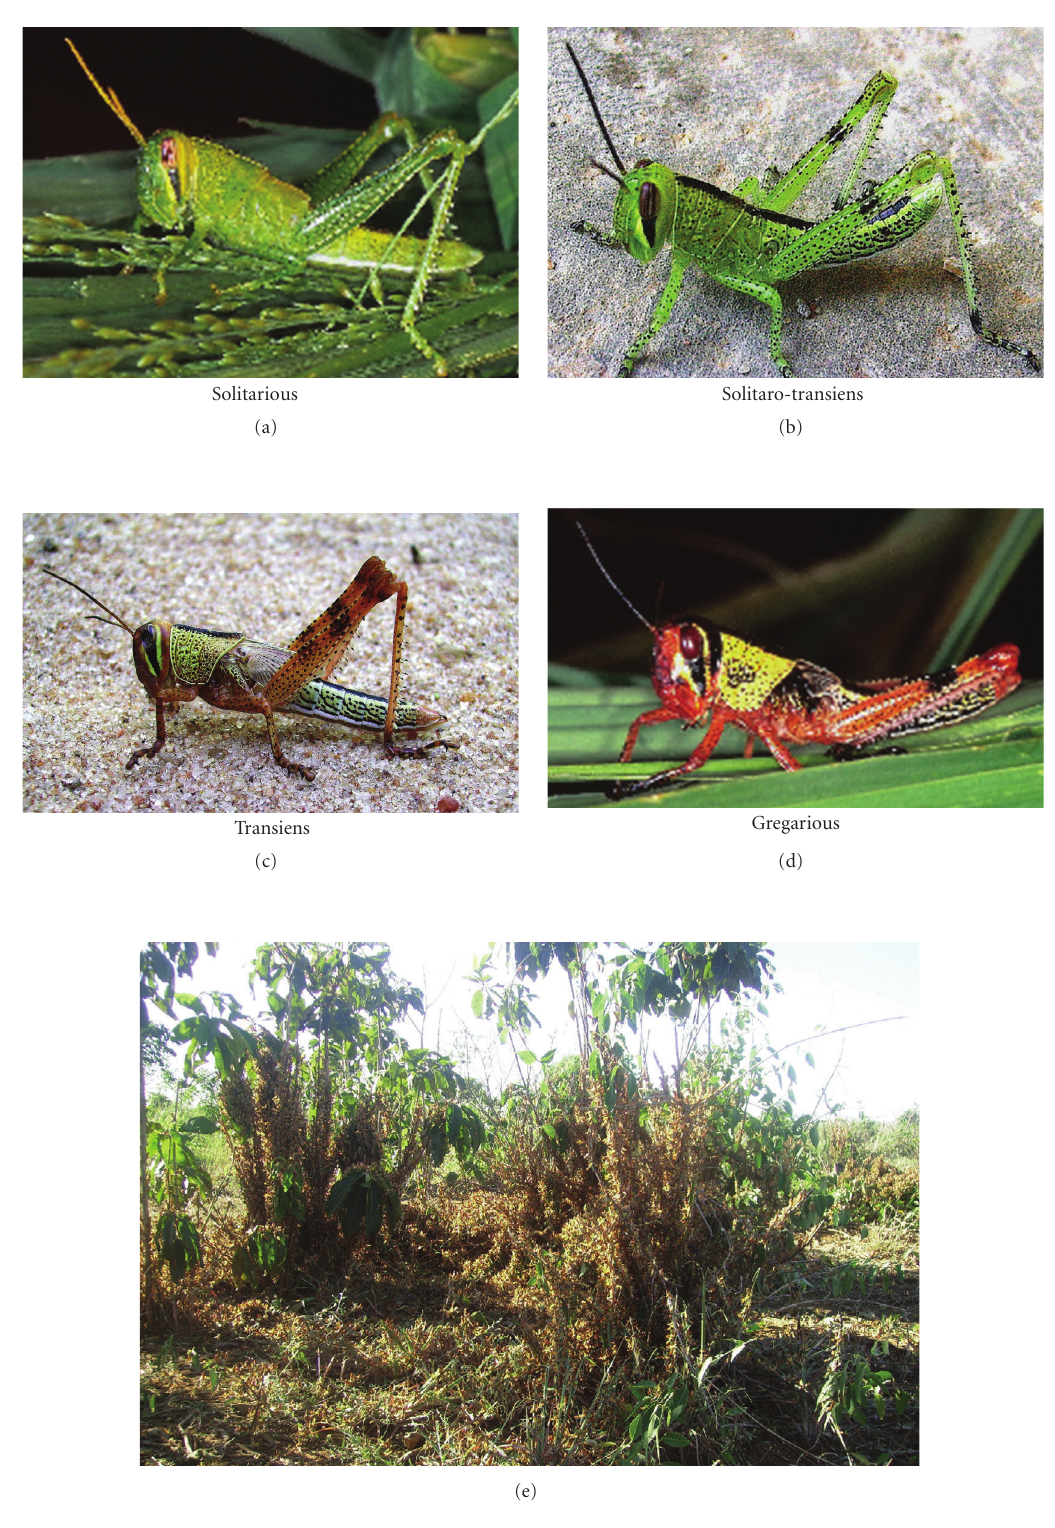
Figure 3: Examples of Red Locust hopper polyphenism (above) and gregarious hopper band (below) observed in February 2008 in the southern part of Madagascar (Mahafaly plateau). Photos: M.H. Luong-Skovmand (solitarious and gregarious) and A. Chamouine (solitaro- transiens, transiens and hopper